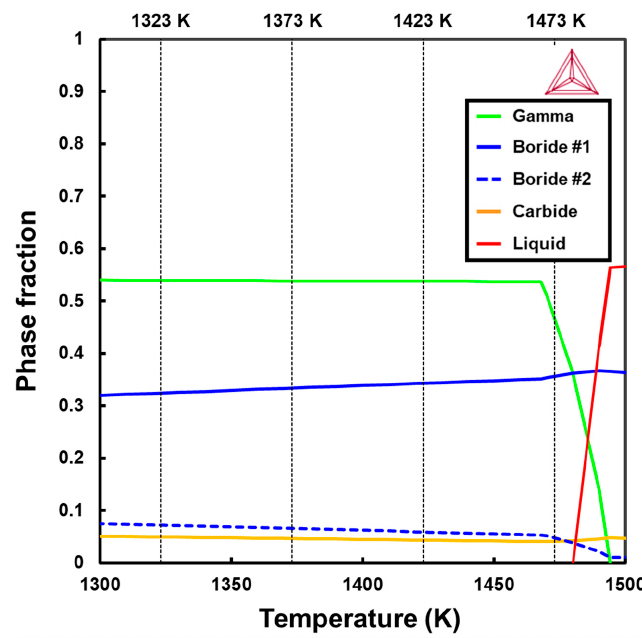
Figure 2. Thermodynamic calculations (Thermo-Calc) of phase fraction as a function of temperature for 1276F alloy.